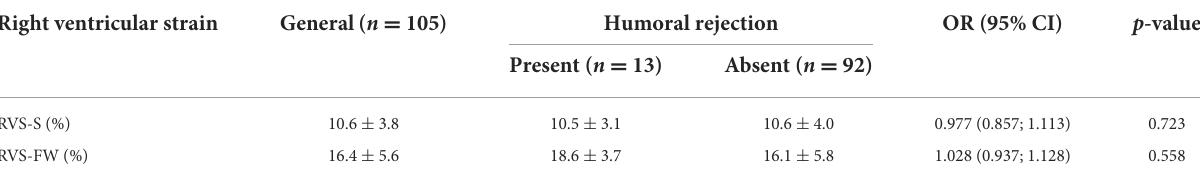
TABLE 13 Right ventricular strain, obtained by offline analysis of the three-dimensional full volume according to antibody-mediated (humoral) rejection identified by immunofluorescence or immunohistochemistry. Right ventricular strain